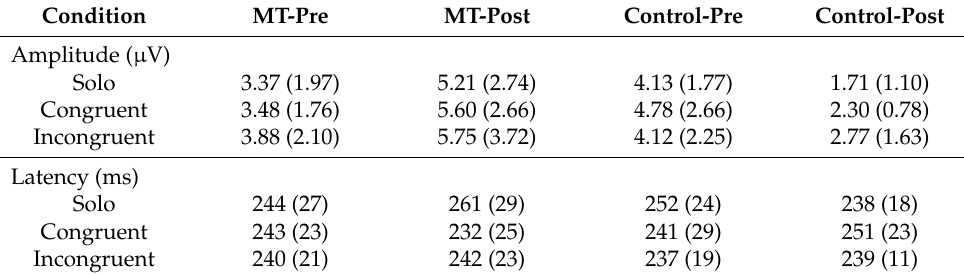
Table 3. ANT ERP amplitudes and latencies pre-/post-intervention.